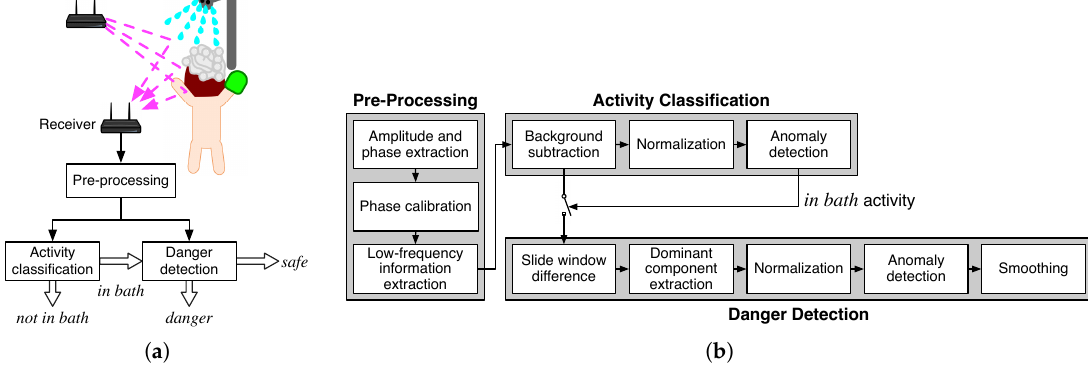
Figure 1. System architecture: ( a ) outline of system architecture, and ( b ) system